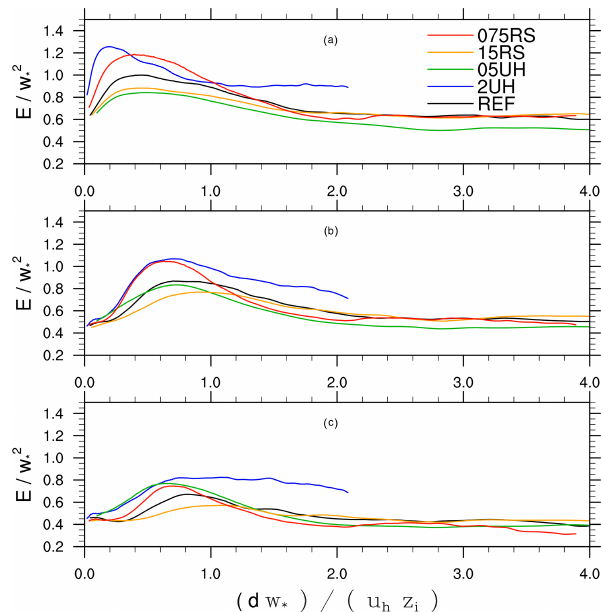
Figure 17. Horizontal profile of 30min time-averaged resolved- scale TKE on 13:00UTC depending on the normalized distance to the inflow boundary at (a) 0 . 1 z i , (b) 0 . 5 z i , and (c) 0 . 75 z i